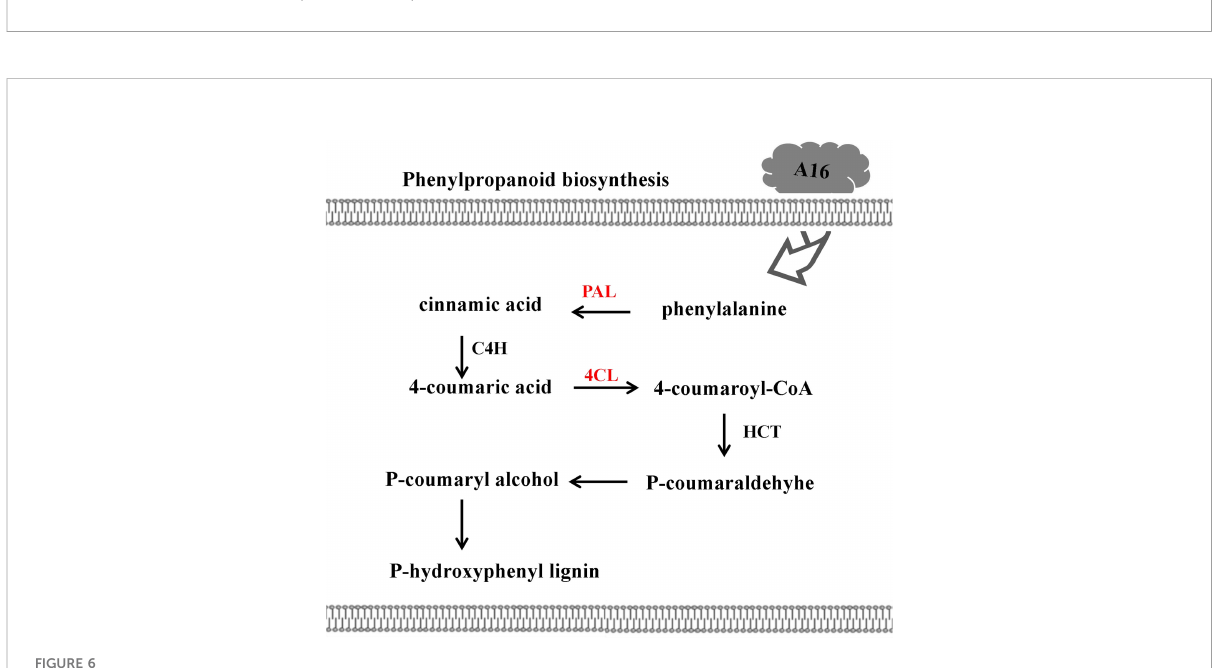
FIGURE 6 Phenylpropanoid biosynthesis pathway in tobacco response to A16. The red color represents upaccumulated proteins in this pathway. PAL, phenylalanine ammonialyaze; C4H, cinnamate acid 4-hydroxylase; 4CL, 4-coumarate-CoA; HCT, hydroxycinnamoyl transferase.